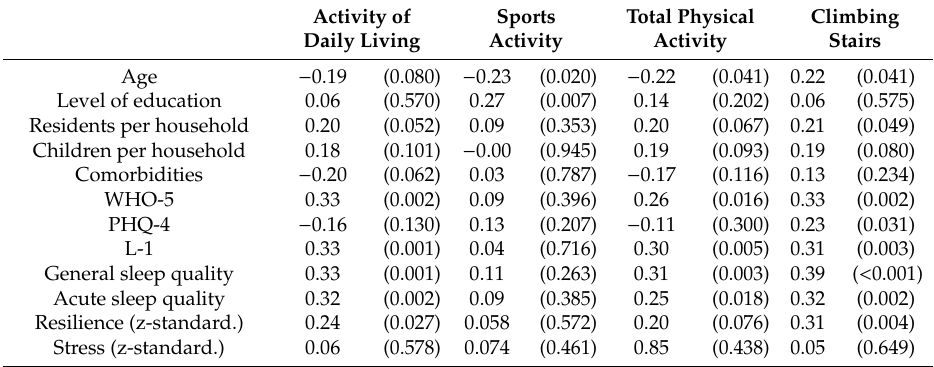
Table 3. Spearman’s rank correlation coe ffi cients for associations between activity scores, sociodemographic data, mental health, and sleep quality of PH patients. Significant associations are depicted in